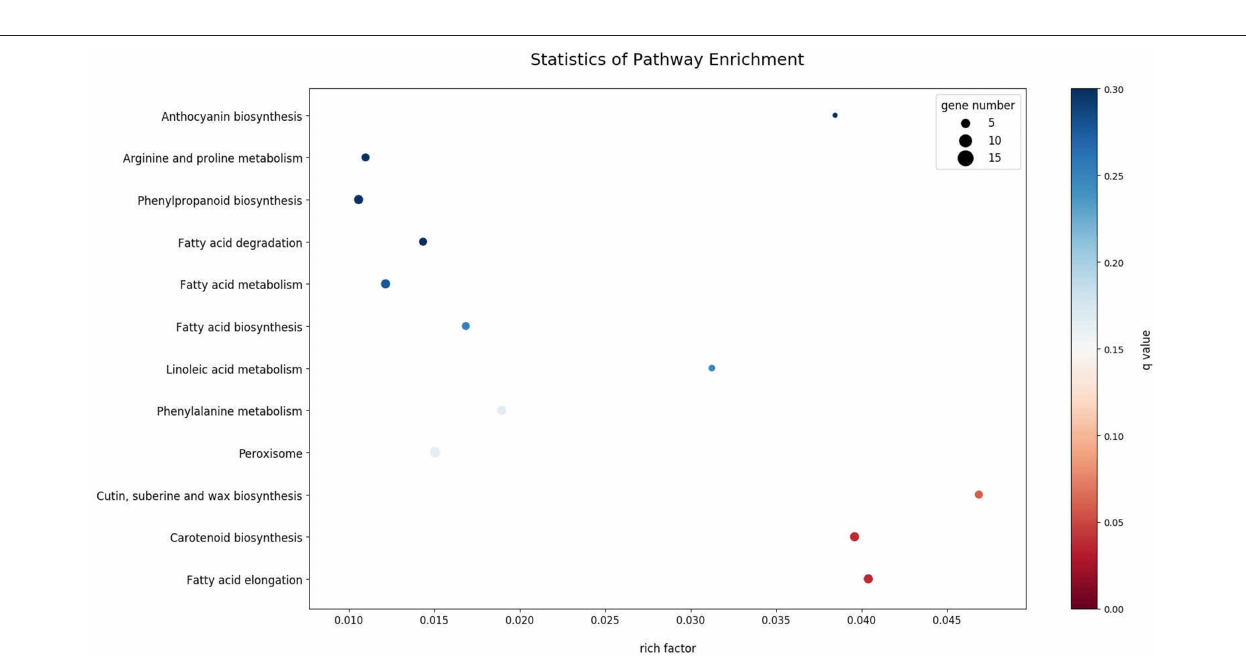
Frontiers in Ecology and Evolution | www.frontiersin.org